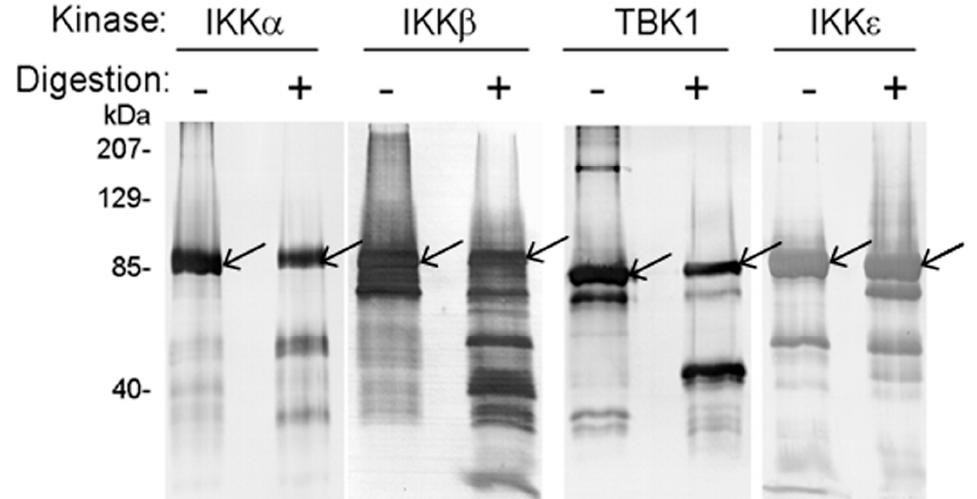
Figure 2. Western blot analysis of in vitro digestion of recombinant human IKK α , IKK β , IKK ε , and TBK1 with NS3/NS4A. The kinases (1.2 µ g) were digested with NS3/NS4A (6.4 µ M NS3 + 94 µ M NS4A) at 23 °C for 29 h. Arrows indicate bands of intact kinases.